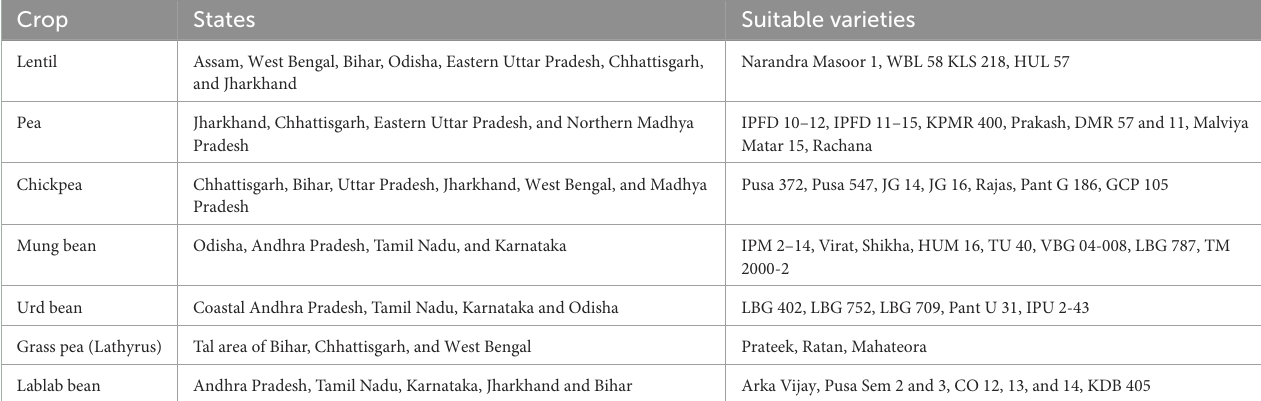
TABLE 8 Potential pulse crops and potential varieties for rice fallows in different states (NAAS, 2016; Singh et al., 2017). Crop States Suitable